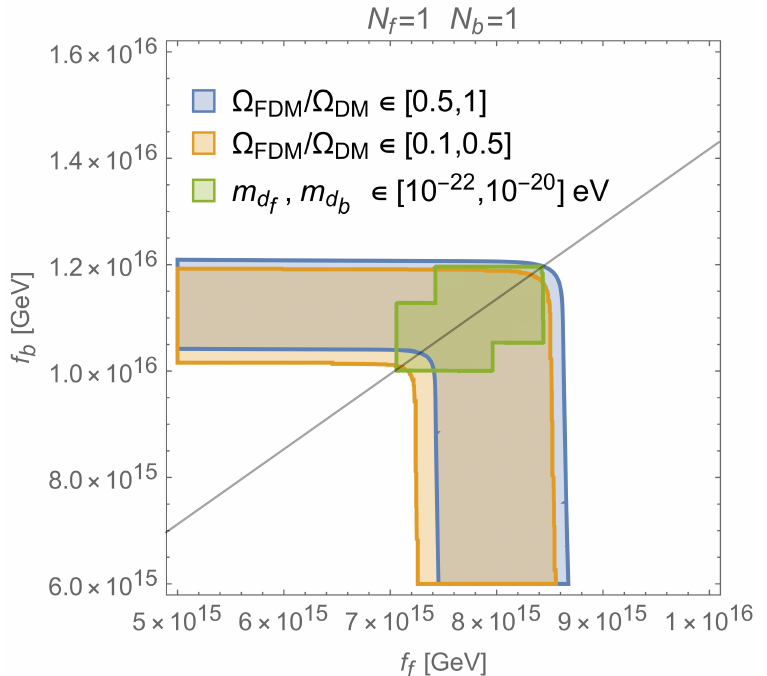
Figure 3 . Allowed percentages of axionic DM as a function of the axion decay constants. The coloured areas satisfy the constraint Ω b h 2 + Ω f h 2 ≤ 1 . The blue and yellow areas refer to regions 0 . 112 0 . 112 where ultralight axionic DM represents different percentages of the total amount of DM of the universe. The green area identifies the region where we have two FDM axions. The black line is √ given by q = f = 2 b /f f